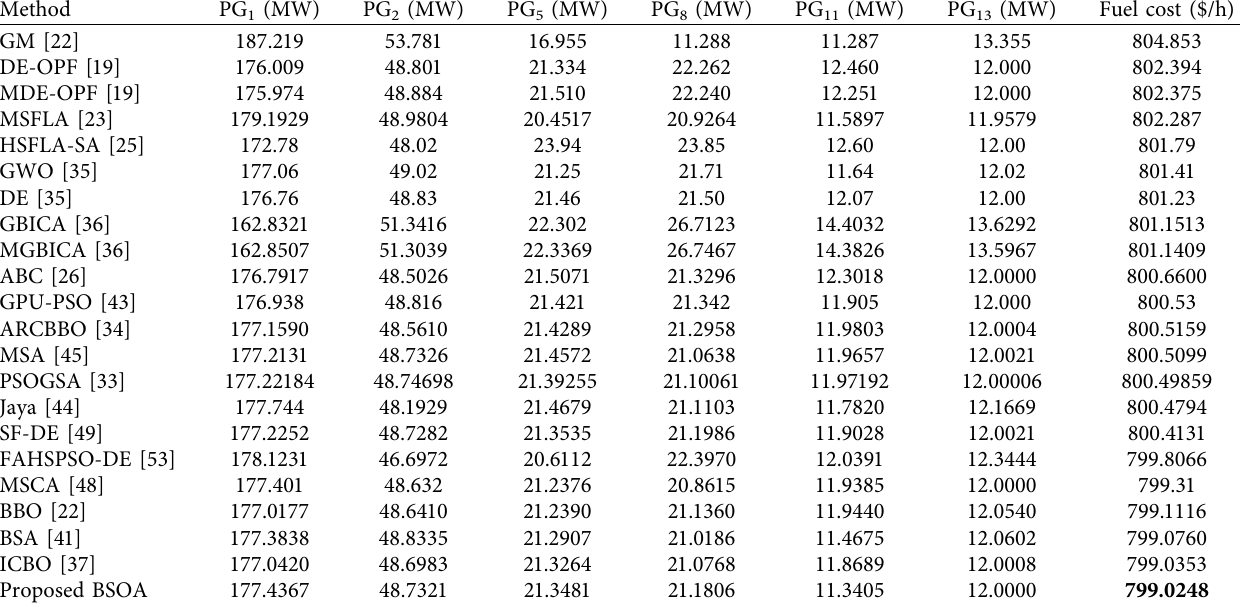
Table 7: Comparison of optimal control variables of generation obtained from diferent recent methods for quadratic fuel cost of the IEEE 30-bus system (Case 1).